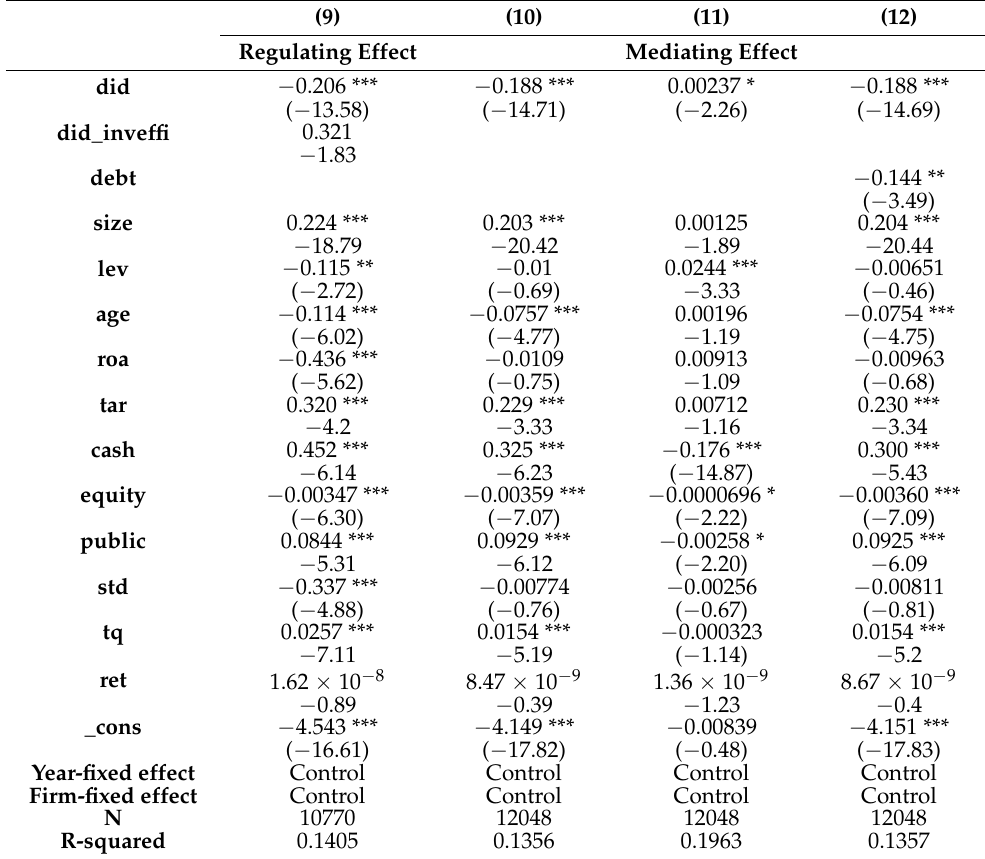
Table 5. Mechanism